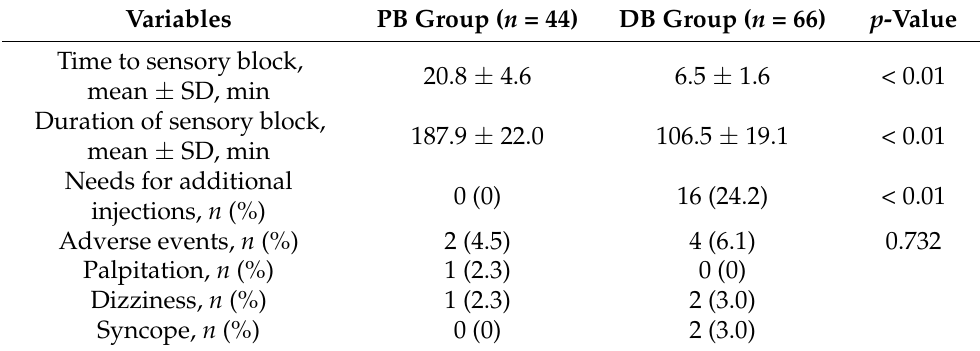
Table 2. Comparison of block characteristics and adverse events between groups a .